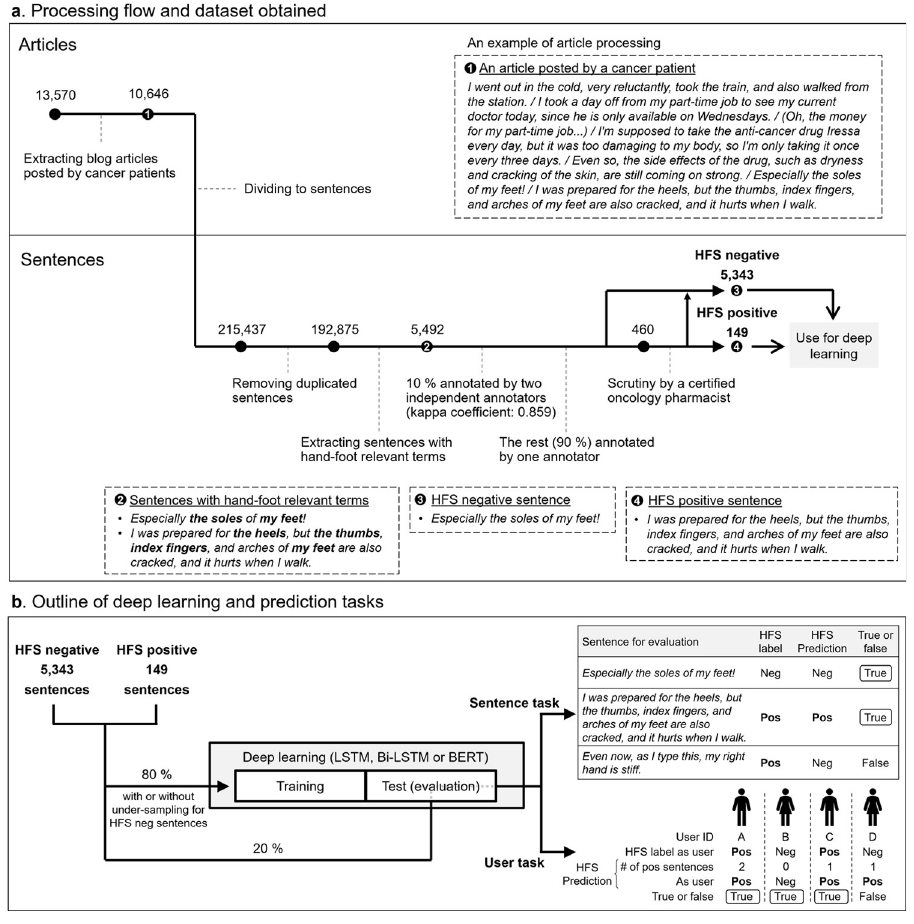
Fig 1. Overview of data processing and deep